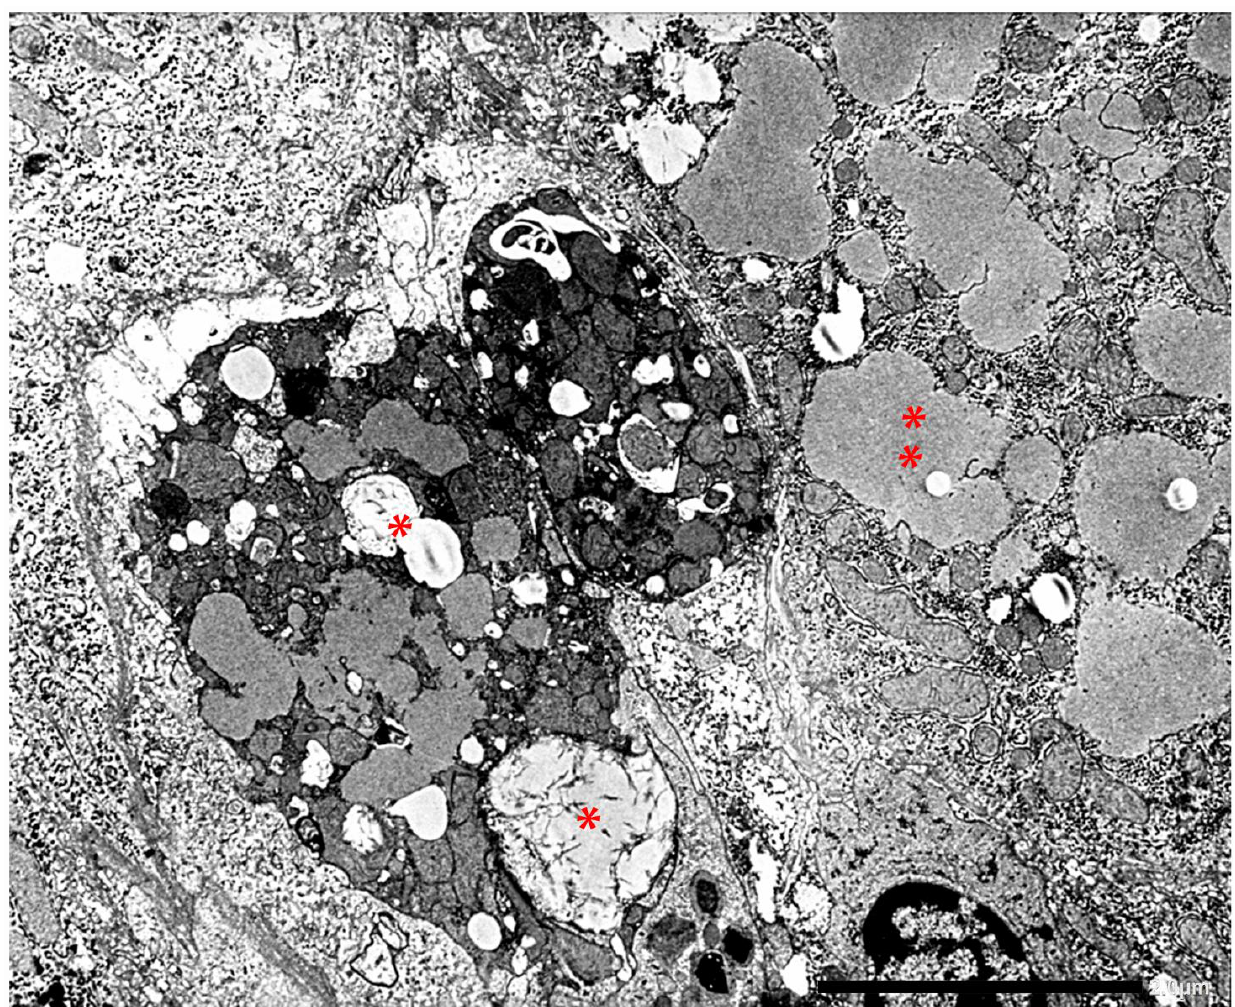
Figure 14. Pi ZZ cirrhotic liver. The electronmicrophotograph shows two adjacent hepatocytes with a dark appearance of the cytoplasm and severe organelle damage. The picture corresponds on light microscopy to apoptotic bodies. AAT-like material is present within dilated cisternae of the RER (**). In a few inclusions, the AAT appearance is dense, compact with remnants of membrane inside (*). Inflammatory cells and bundles of collagen type I are seen all around the apoptotic cells (EM × 6160). (Figure obtained from Callea F. PhD Thesis. Acco, Leuven 1983: 1–153.